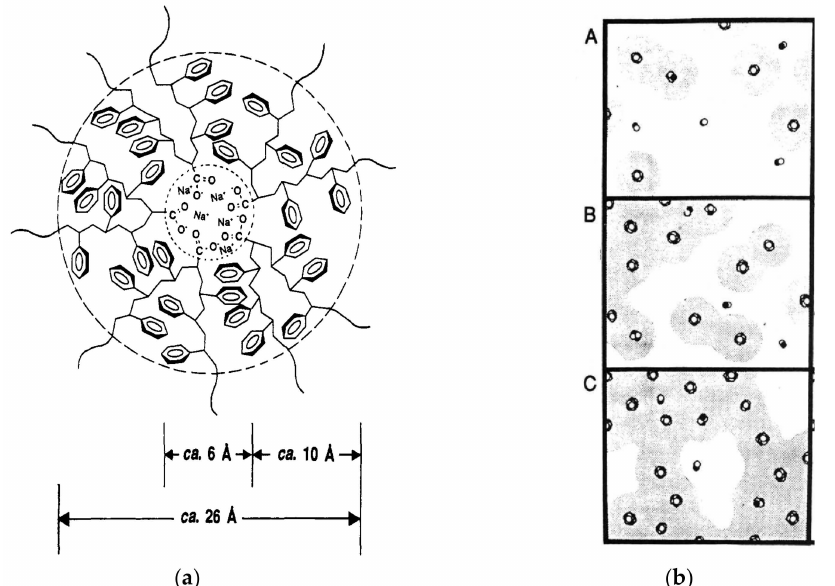
Figure 1. Schematic representation of the ( a ) region of restricted mobility surrounding a multiplet and ( b ) morphologies of random ionomers at different ion contents: (A) low, (B) intermediate and (C) high ion content. Adapted from Ref. [2]. Reprinted with permission from A new multiplet-cluster model for the morphology of random ionomers. A. Eisenberg, B. Hird, and R. B. Moore.